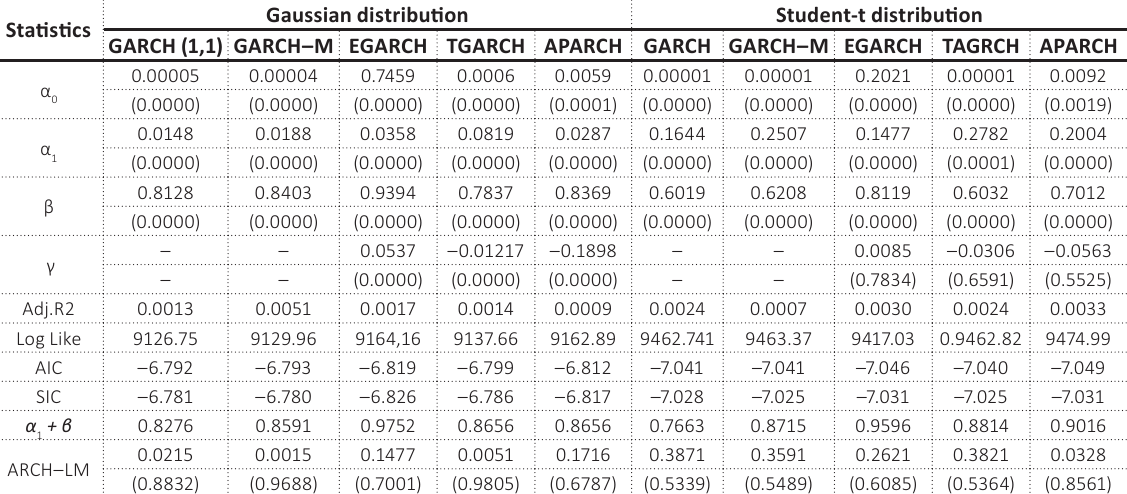
Table 6. Estimation result of GARCH models: Gold